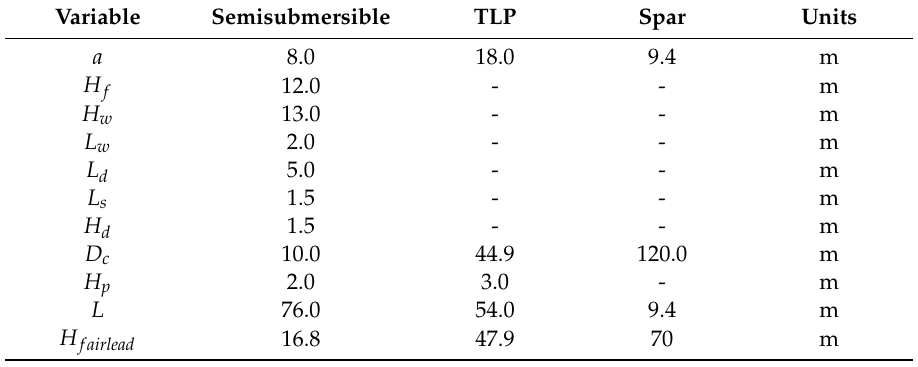
Table 1. Characteristics of the platforms [47].